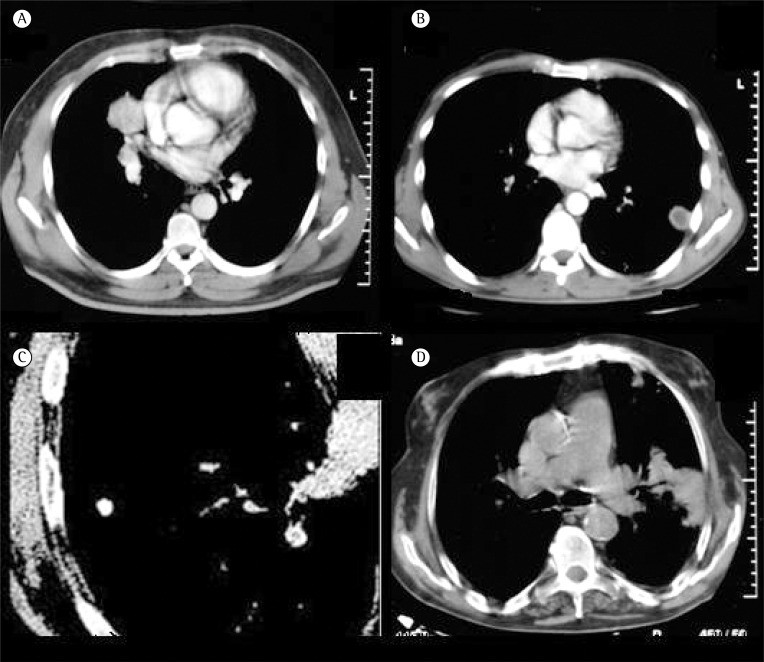
Helical CT scans showing intralesional changes, including homogeneous
attenuation (in A; male patient, 49 years old), necrosis (in B; male patient,
36 years old), calcification (in C; male patient, 56 years old), and air
bronchogram (in D; male patient, 77 years old).